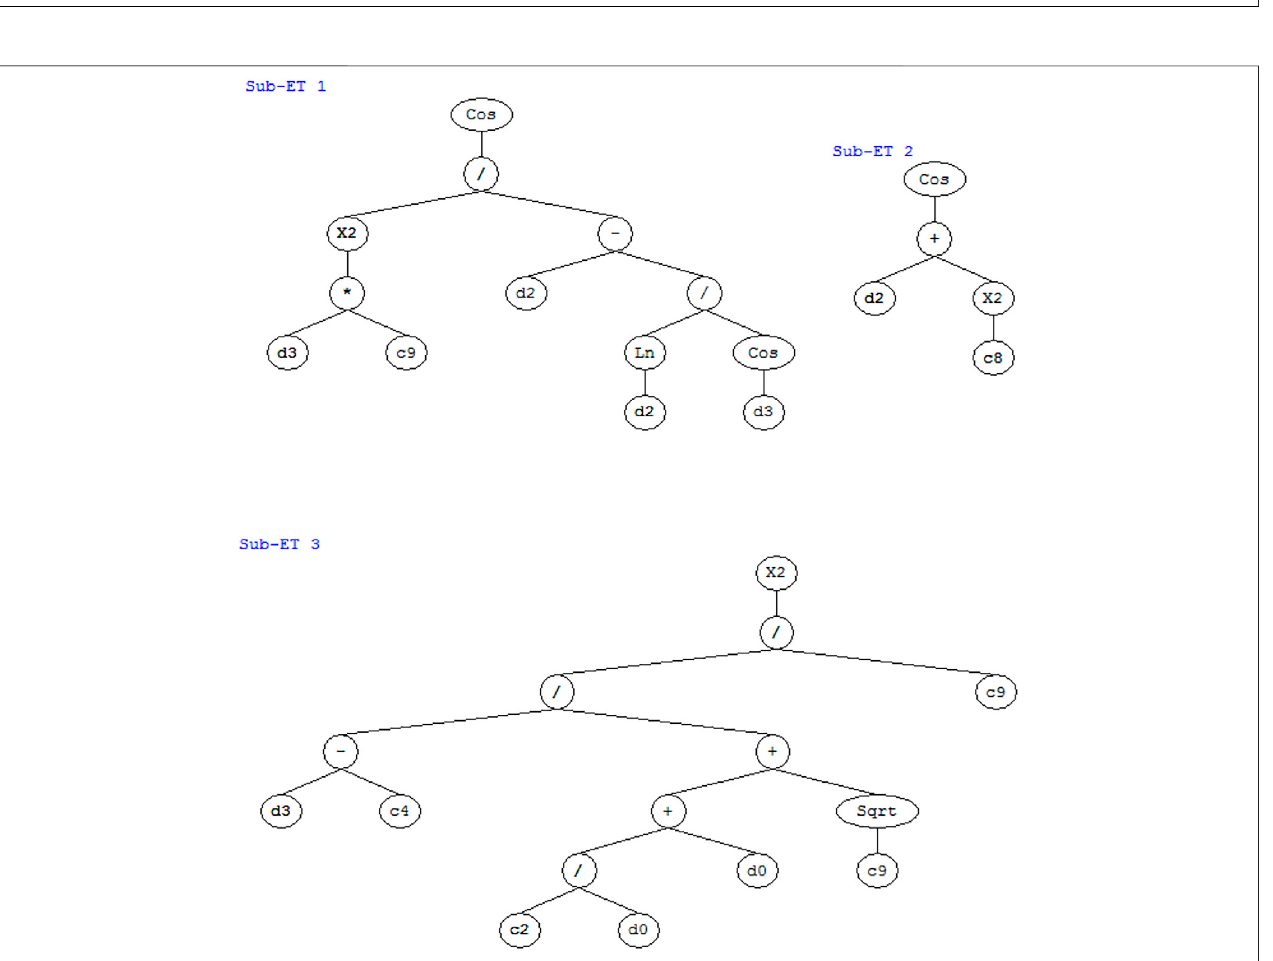
FIGURE 6 | Schematical representation of the ANN